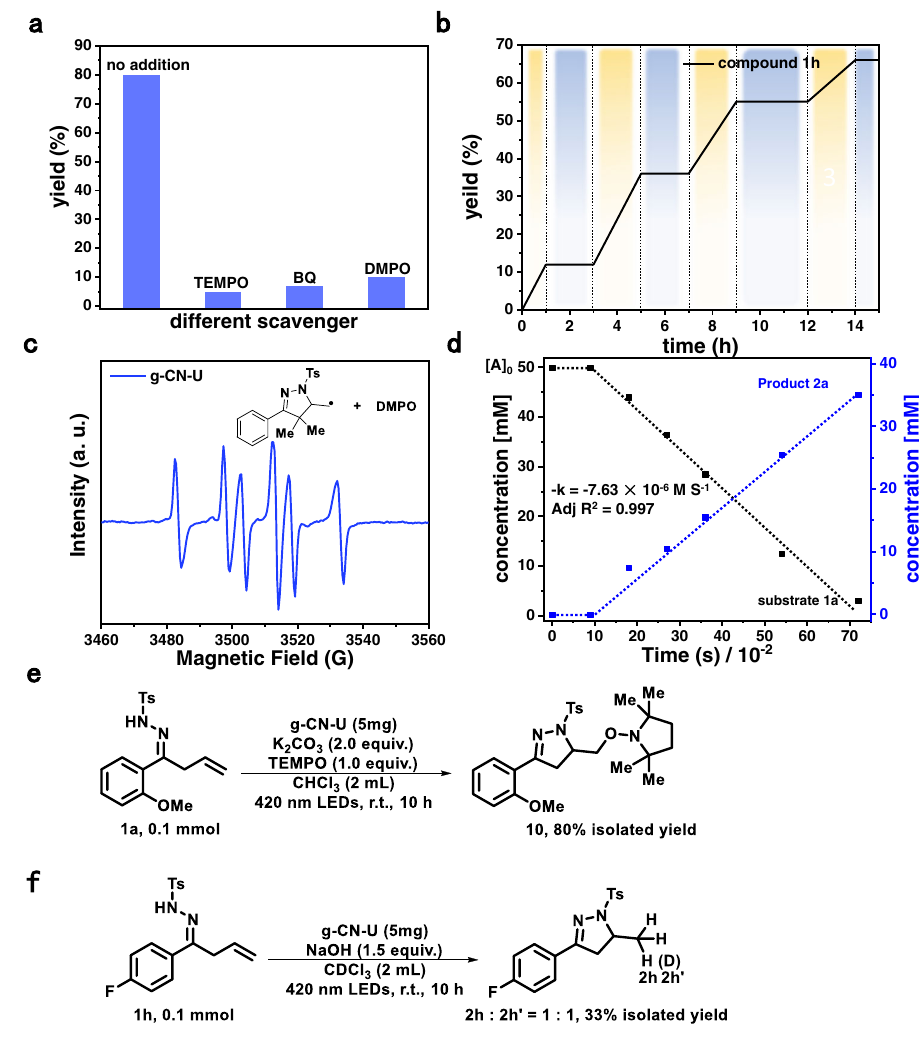
Fig. 3 | Mechanistic studies. a Radical scavenging experiments. b Light on-off experiments. c ESR spin trapping experiments. d Time pro fi le of photocatalytic